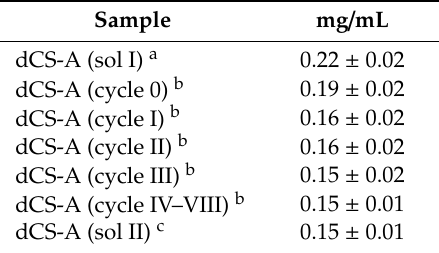
Table 5. Average concentration of the fully-soluble dCS-A in pure water collected as the sample went through freeze–thaw cycles. Values represent an average of four samples.